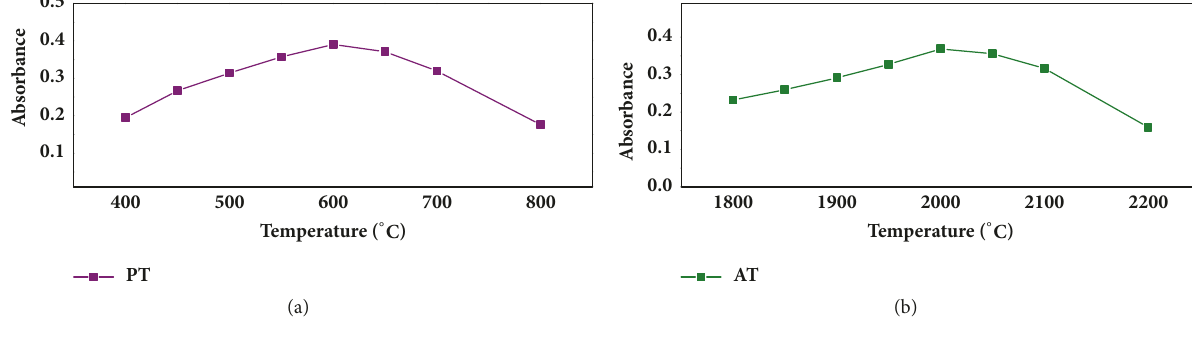
Figure 4: (a) The absorbance of Sb (III) with the pyrolysis temperature (PT) from 400 ∘ C to 800 ∘ C. (b) The absorbance of Sb (III) with the atomization temperature (AT) from 1800 ∘ C to 2200 ∘